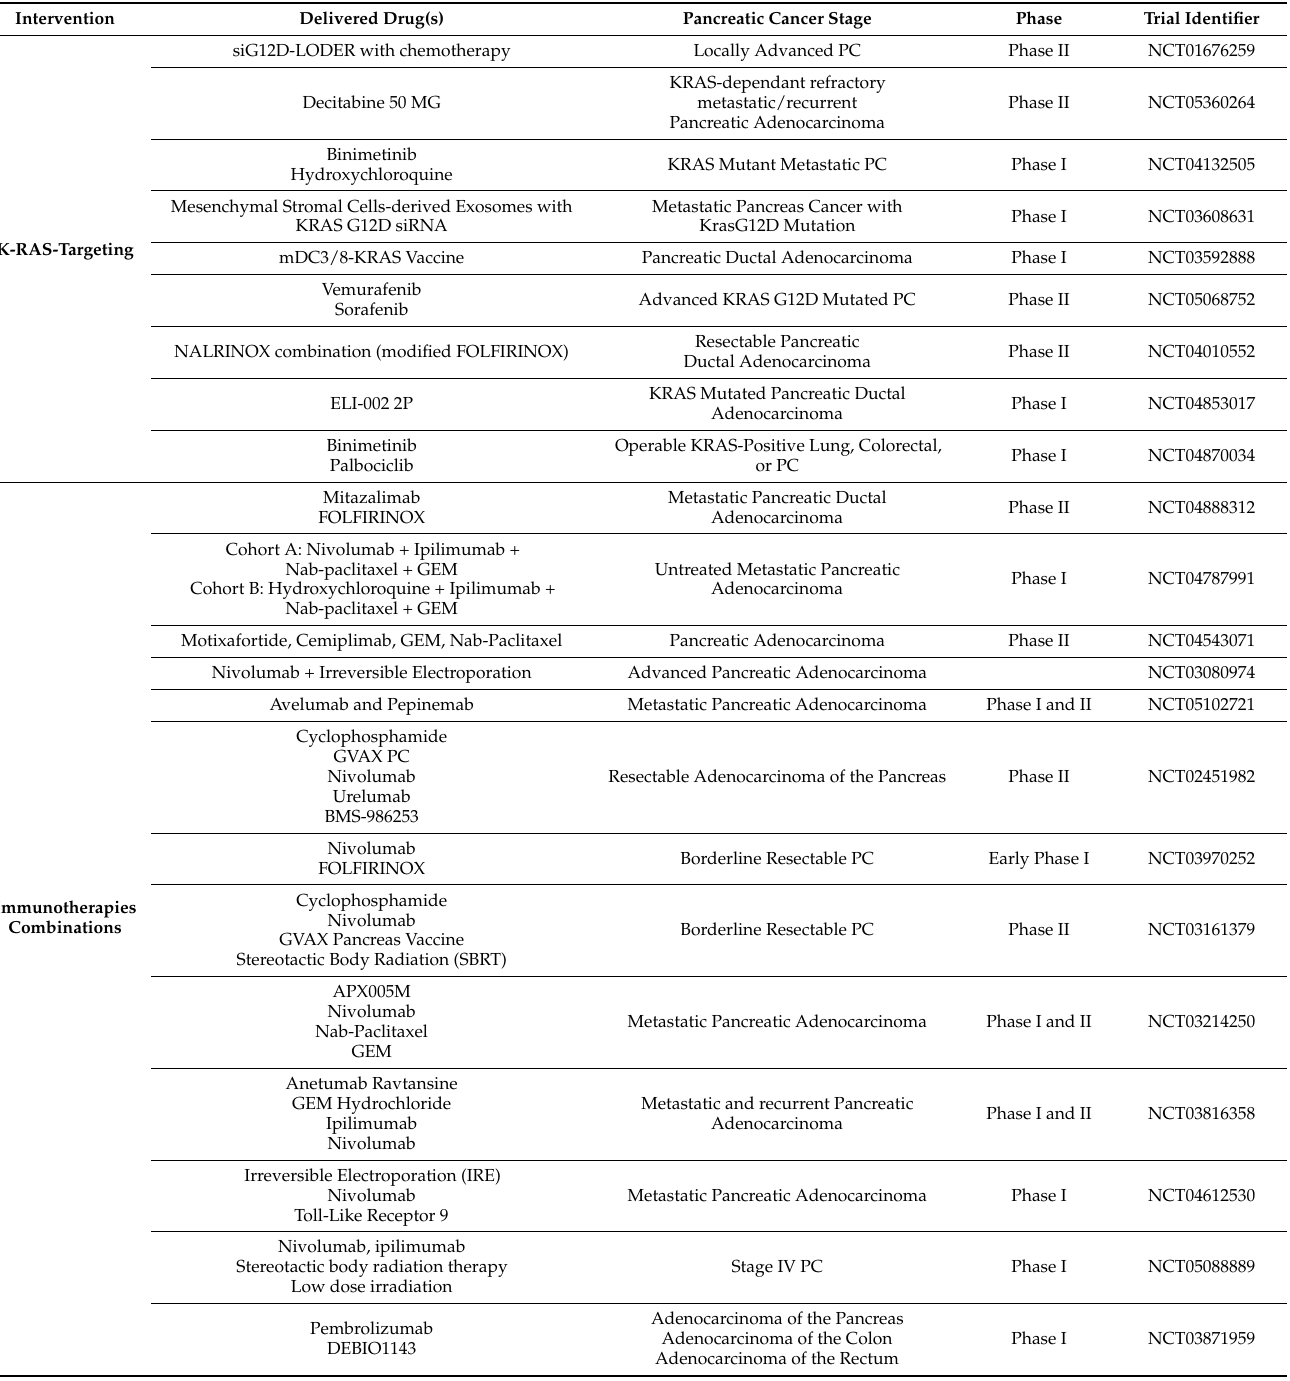
Table 1. Current novel therapies in clinical trials. Information was obtained from